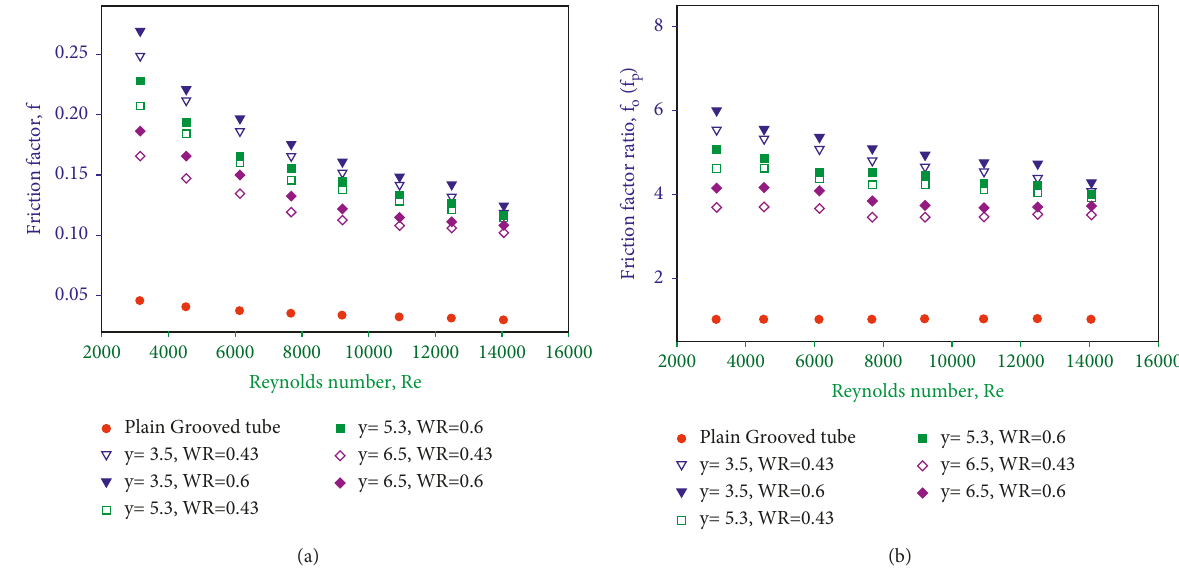
Figure 9: Friction factor of W-cut insert: (a) f vs. Re. (b) f